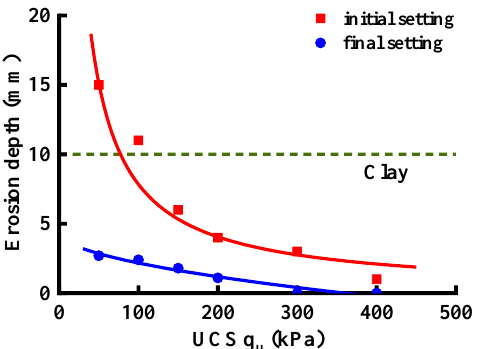
Figure 18. Relationship between the UCS and equilibrium erosion depth.